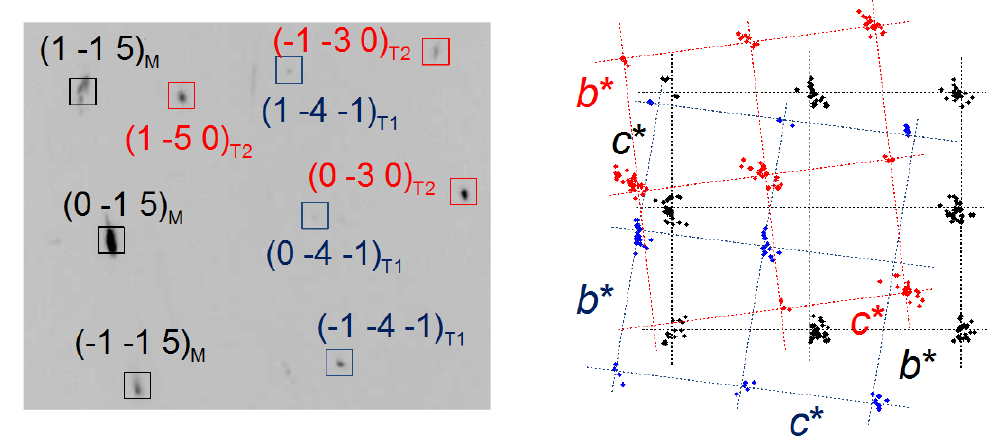
Figure 4. Section of one single-crystal X-ray diffraction frame of MnWO 4 ( left ) showing the existence of the reflections of two HP triclinic domains (T1, T2) along the monoclinic (M) reflections. The corresponding projection of the reciprocal space on the ( b *; c *) plane ( right ). Dots represent the location of the measured reflections projected along the a *-axis. The axes of the unit cells are shown as dashed lines. The monoclinic reflections are in black, while the triclinic reflections of the two domains are in blue (T1) and red (T2).